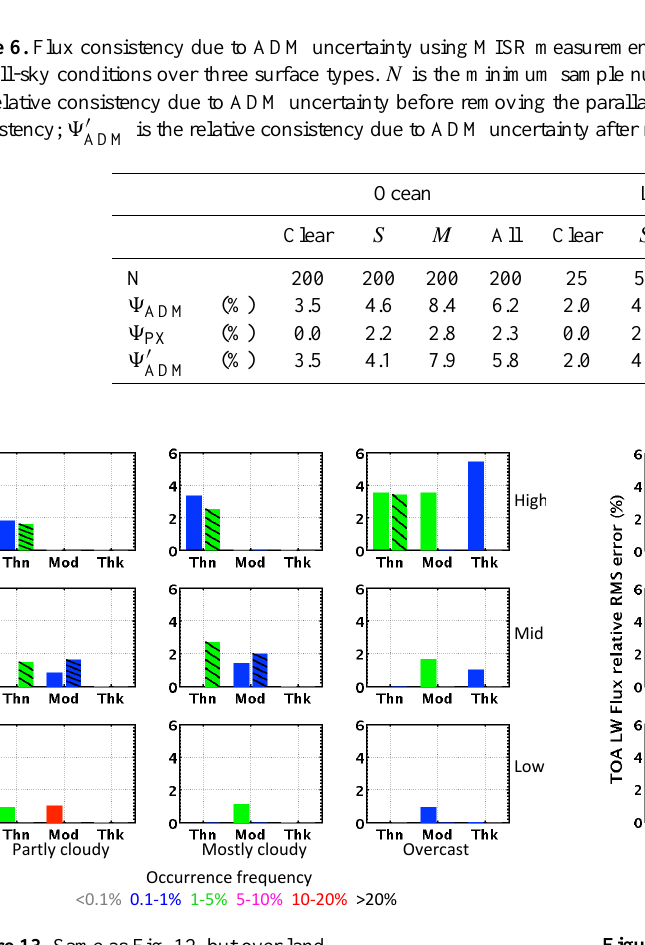
Figure 13. Same as Fig. 12, but over land. Figure 14. Same as Fig. 12, but over snow and